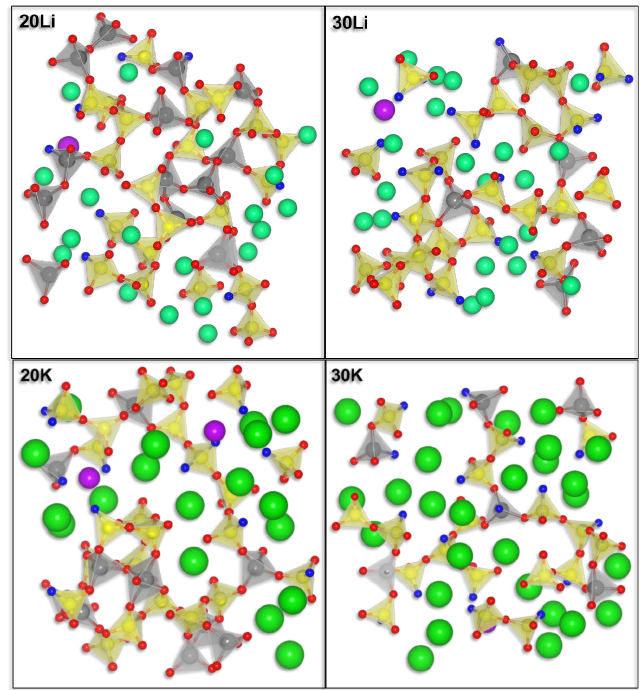
Materials 2021 , 14 , x FOR PEER REVIEW 7 of 19 Figure 2. Schematic representation of alkali aluminosilicate glass network fragments comprising [SiO 4 ] (yellow) and [AlO 4 ] − tetrahedra (grey) as network formers, bridging (red) and non-bridging (blue) oxygen atoms and network modifier ions Li + and K + (green) and Gd 3+ (purple).